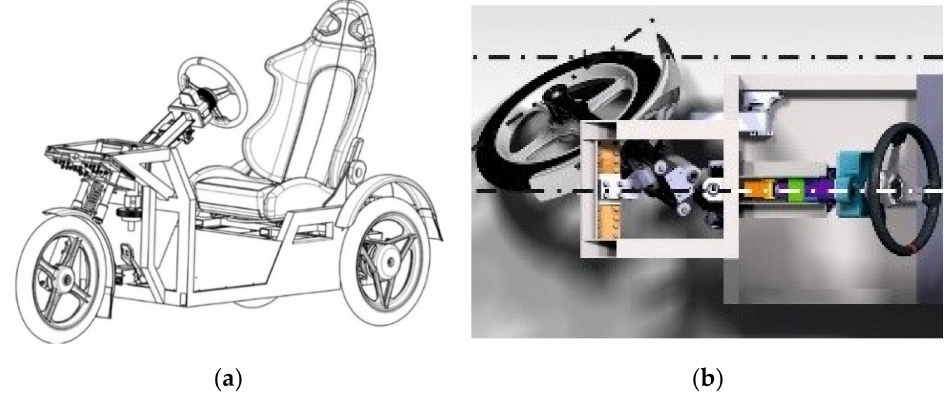
Figure 1. ( a ) The 3D prototype model of the suspension design for the front steered wheel of a three-wheeled vehicle with the patented steering mechanism [23]; ( b ) the motion possibilities of the front